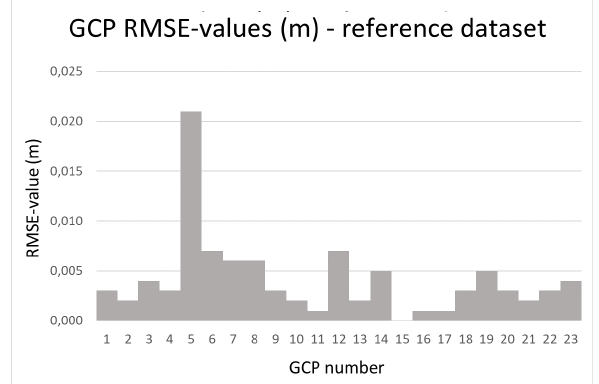
Figure 3: Column chart showing the RMSE-values of the com- parison of the GCP locations determined by total station and their location after registration. Except for one outlier, GCP 5, the RMSE-values are lower than 7 mm. Figure 4: Boxplots giving an overview of the well indicated GCP